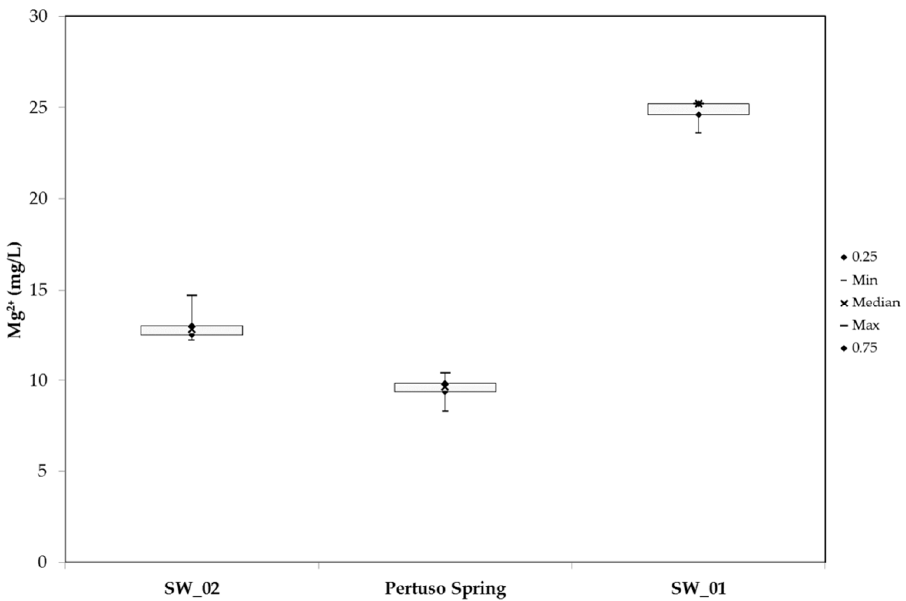
Figure 9. Box plot of mean, median, maximum, and minimum values of magnesium distribution.